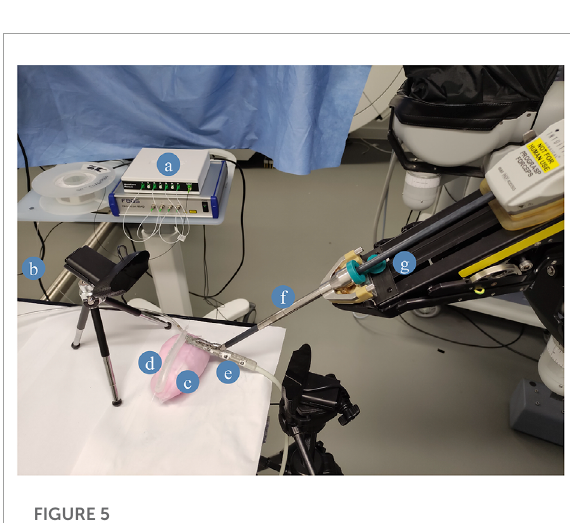
FIGURE 5 Case study experimental setup. (A) FBGS Interrogator and Fan-Out Box: the fan-out is used to connect the multicore shape-sensing fibre to the optical interrogator. (B) FBGS DTG fibre. (C) PVA kidney phantom. (D) DS30 PAF Rail. (E) BK X12C4 Drop-In Ultrasound Probe. (F) EndoWrist Prograsp Forceps, (G) da Vinci surgical